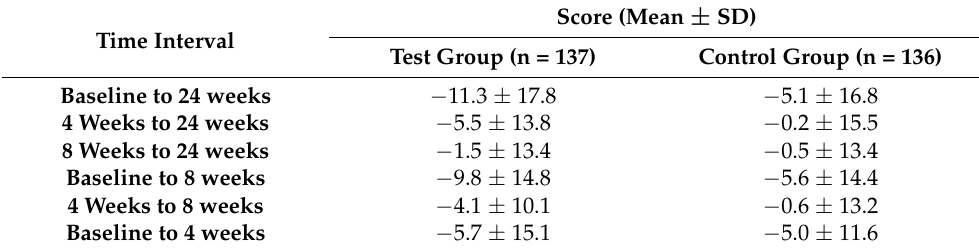
Figure 1. Estimated marginal means of the OHIP-49 scores at 24 weeks. Table 4. Changes in the OHIP-49 scores during the treatment of 24 weeks.